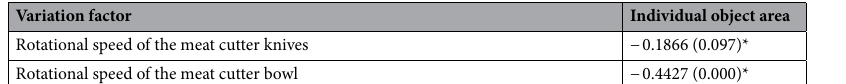
Variation factor Individual object area Rotational speed of the meat cutter knives − 0.1866 (0.097)* Rotational speed of the meat cutter Table 6. The linear correlation between the area of individual objects and the variation factors under analysis (the processed meat products). *significance levels of correlation coefficients ( p ≤ 0.05).